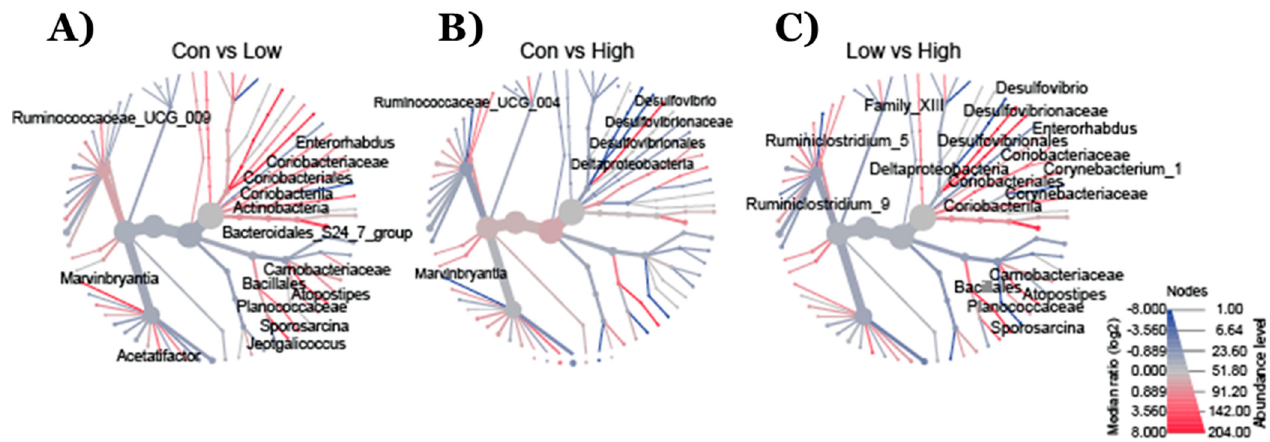
Figure 3. ( A ) Phylogenetic heat tree illustrates the differences in relative bacterial abundance between groups. The data show the changes in the bacterial families in mice fed ( A ) TRP-deficient/low compared to TRP-normal, ( B ) TRP-rich/high compared to TRP-normal, and ( C ) TRP-rich/high compared to TRP-deficient diets. Control diet ( n = 7), TRP-deficient diet ( n = 7), and TRP-rich diet ( n = 7). Red nodes represent more abundant bacterial families, whereas the blue nodes represent less abundant bacterial families.